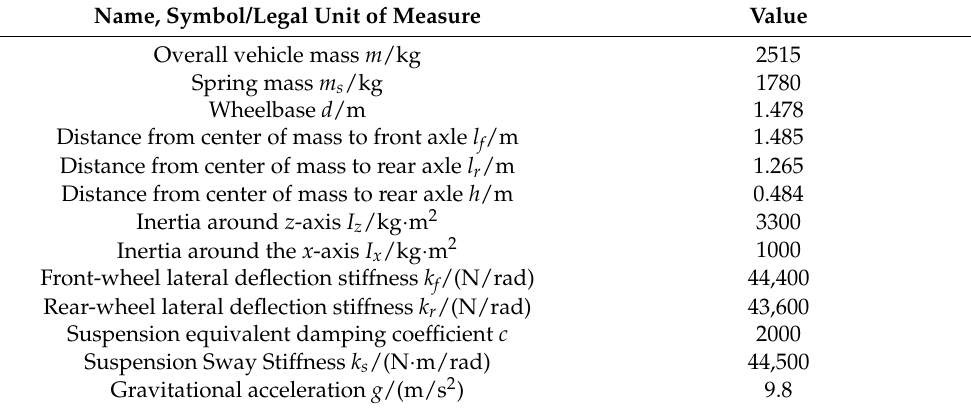
Table 1. Parameters of intelligent inspection vehicles for forest land.